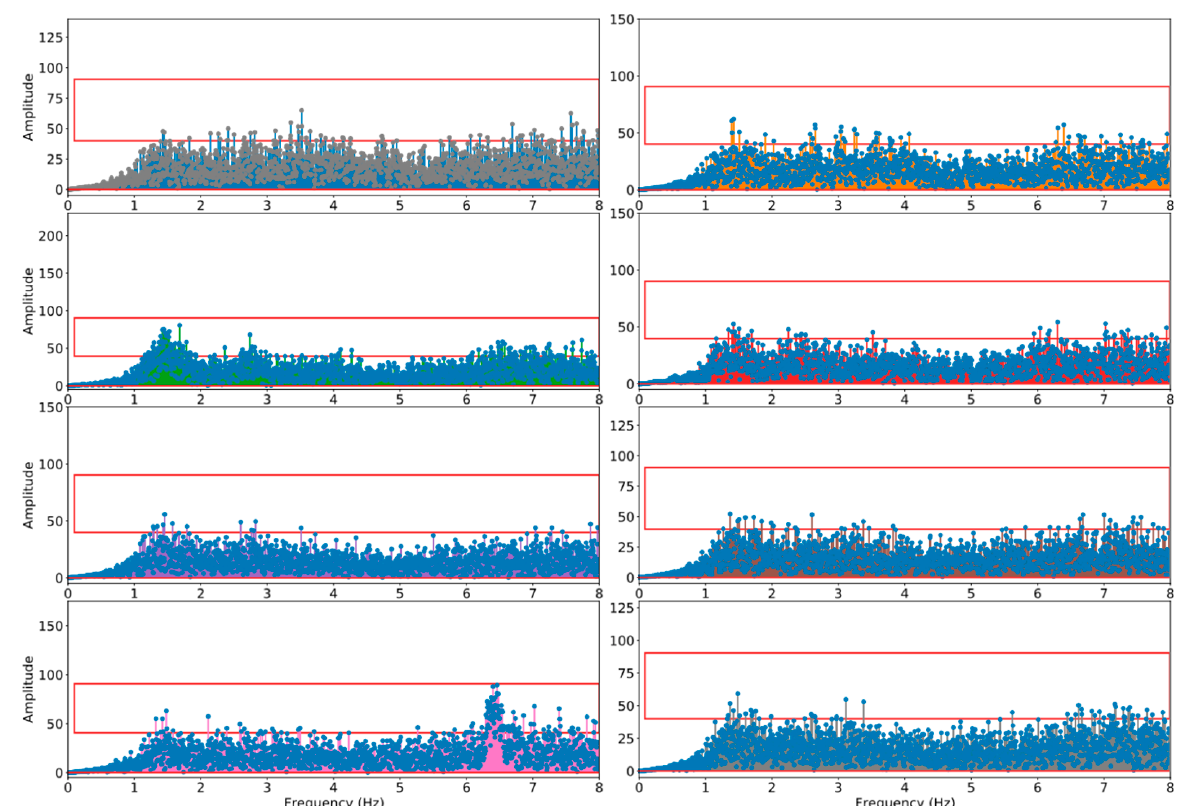
Figure 4. Filtered signals after the removal of periodical signals. The intention is to keep the frequency band narrow enough so that the filtered signals only exhibit the characteristics of defect-related events. The boundary frequencies are also known as the cutoff frequencies. A first-order Butterworth filter [21] was chosen experimentally for the filtering process, i.e., a bandpass for frequency band (0.1–0.5) Hz. With the average driving speed of 30 ± 5 Km/h and a 16-Hz sampling rate, Figure 5 shows the road surface condition of the first 500 m, and the corresponding accelerometer readings. The vertical bars in various colours indicate the manually labelled defects, including potholes (light blue), distortion (light orange), rutting (light green), and patching (pink). It is now much easier to observe how the accelerometer readings reflect the abnormal events corresponding to many of the actual defects. The width of the vertical bars indicates an approximate region where the defect was observed; this was done by mapping GPS readings in the collected data to the GPS coordinates recorded in the photos taken at the site of the defects. However, due to the level of accuracy of GPS for civilian use, the GPS coordinates recorded by different devices and at a different travelling speed may not be an exact match. Thus, in order to accommodate the potential drifts at a certain level, a defect is marked in a range. In this work, the width of the vertical bar corresponds to 4.9 m (or higher, depending on the environment); this is the main reason that the vertical bars shown in Figure 5 have some overlaps. An example of each type of defect is shown in Figure